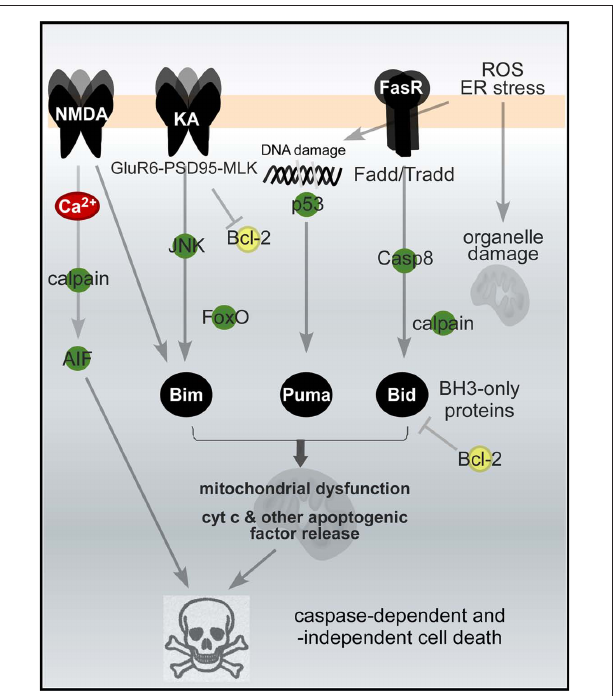
FiguRE 2 | Apoptosis-associated signaling pathways activated in neurons by seizures. Signaling pathways downstream of glutamate and Fas (death) receptors turn on BH3-only proteins of the Bcl-2 family, culminating in mitochondrial dysfunction and caspase-dependent and -independent cell death. The list is not complete and represents only some of the major pathways. Abbreviations: AIF, apoptosis-inducing factor; casp8, caspase-8; ER, endoplasmic reticulum; Fadd, Fas-associated death domain protein; FasR, Fas death receptor; JNK, Jun-terminal kinase; KA and NMDA, glutamate receptor subtypes; ROS, reactive